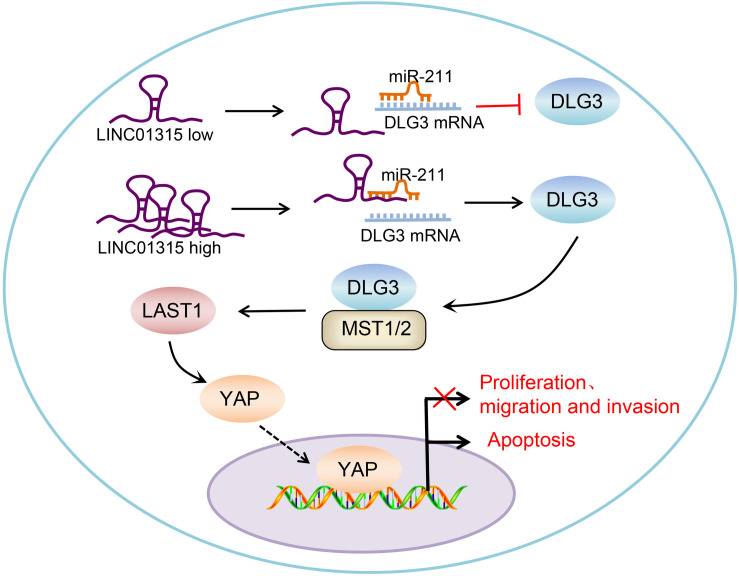
Diagram illustrating the molecular mechanism of LINC01315 in proliferation, invasion, and migration of OSCC cells. LINC01315 can competitively bind to miR-211 and attenuate the binding of miR-211 to DLG3, which promotes the binding of DLG3 to MST1/2, leading to activation of the Hippo signaling pathway. The reduced translocation of YAP protein into nuclei correspondingly led to suppression of the proliferation, migration and invasion of OSCC cells and promotion of cell apoptosis.